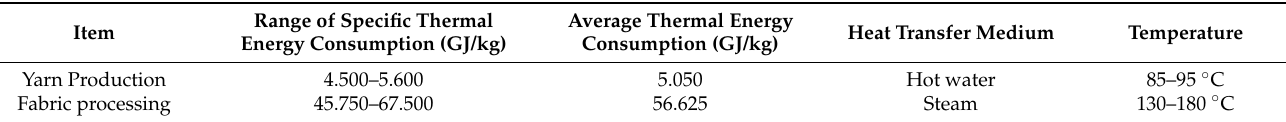
Table 3. Consumption requirement of thermal energy in textile production